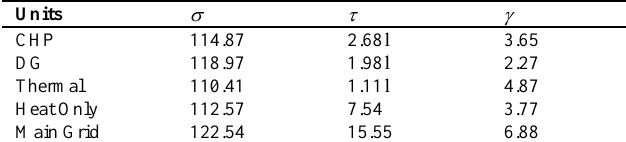
TABLE II E MISSION F ACTORS OF U NITS AND THE M AIN G RID